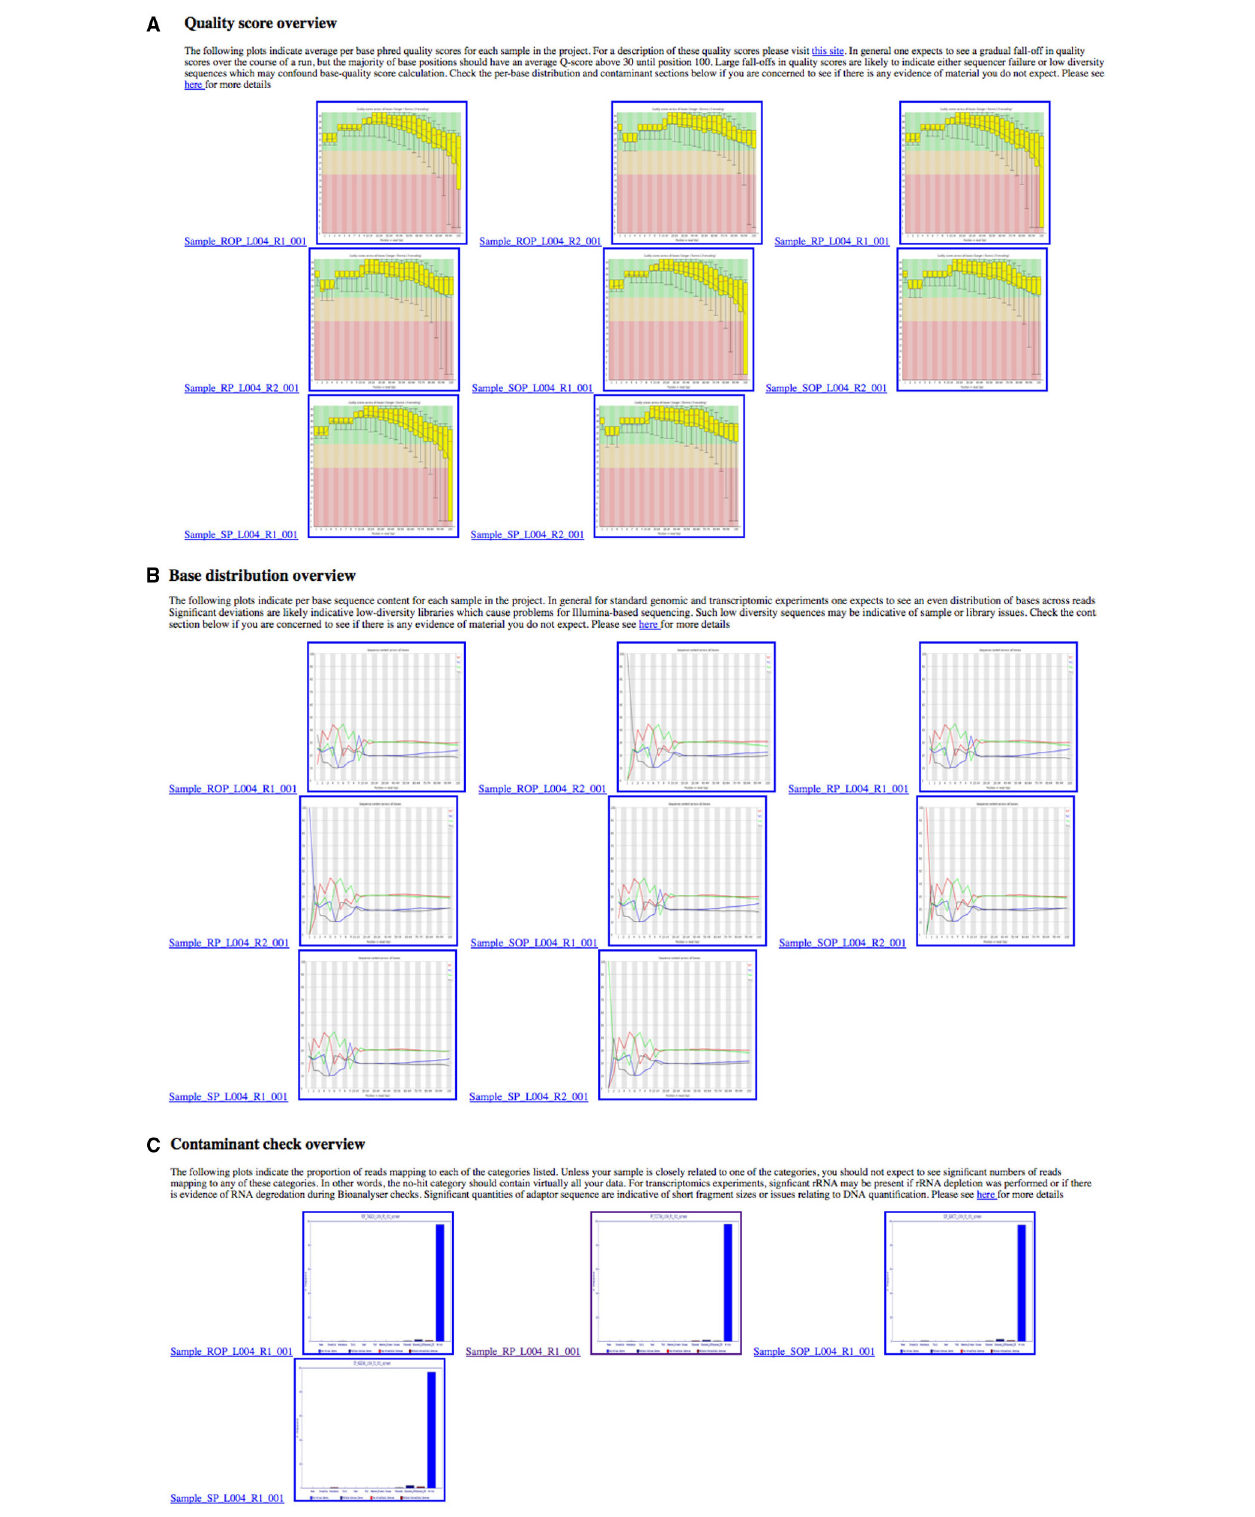
FIGURE 4 | Overview of quality control metrics across multiple samples in a project. These plots are collated into a single HTML summary file for each project, making it easy to see any quality (A) , nucleotide (B) , or contaminant (C) issues at-a-glance.